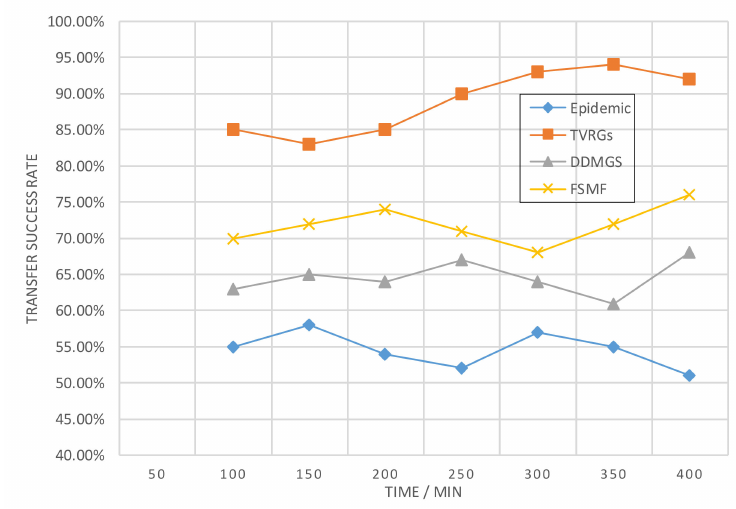
Figure 8. The relationship between transfer success rate and simulation time.